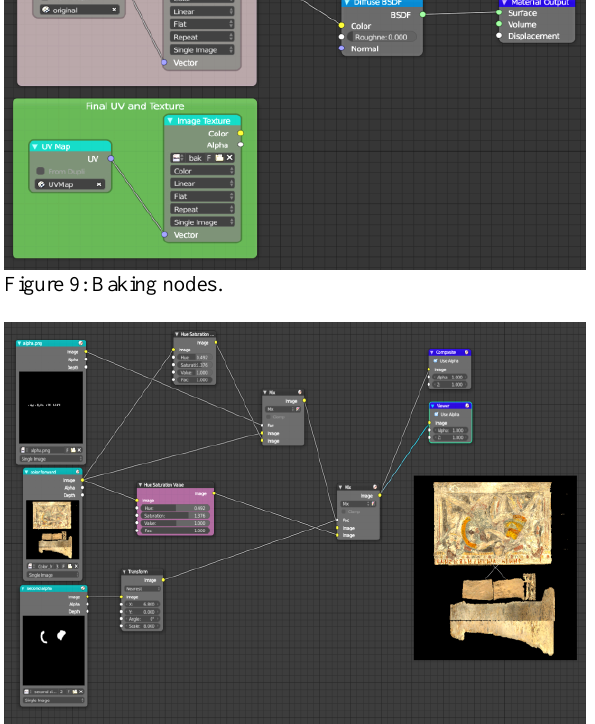
Figure 10: Masking process and colour correction process (non- destructive).